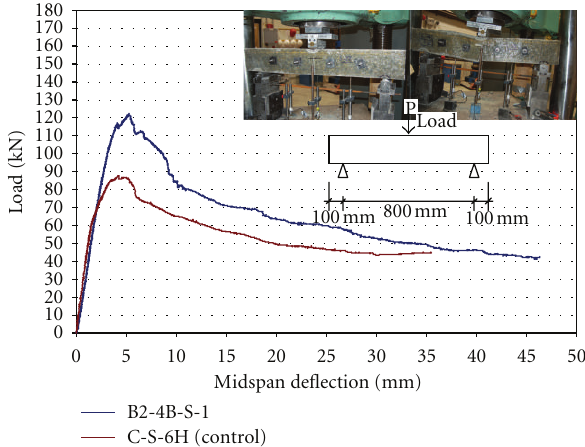
Figure 23: Load versus midspan deflection of RC beam B2-4B-NS- 1.